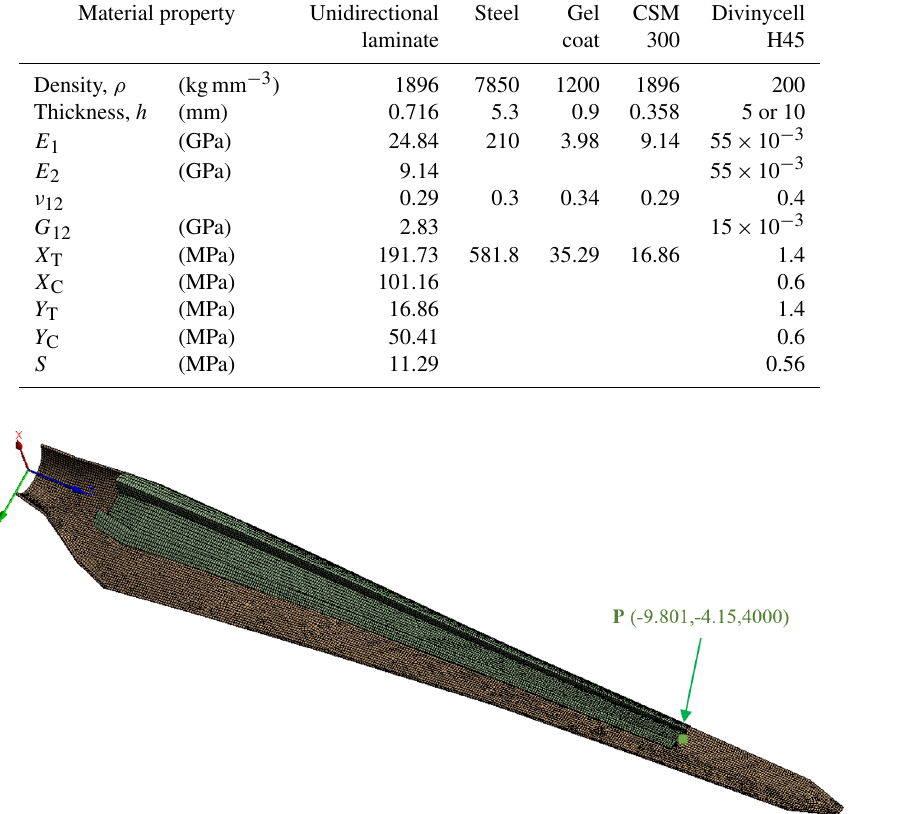
Figure 6. Location of the load measurement coordinate system and the deflection measurement point P .